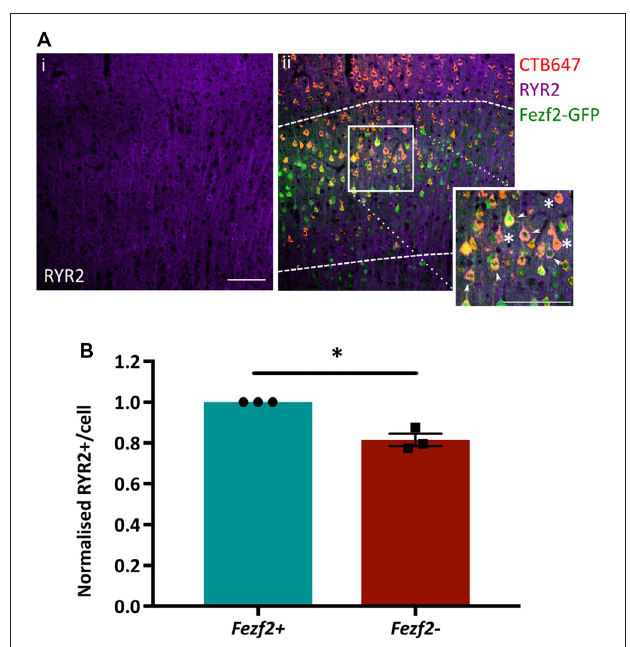
FIGURE 6 | Validation of enriched RYR2 expression in Fezf2+ve IT-PNs by immunohistochemistry. Coronal sections from CTB647 injected Fezf2-Gfp mouse were labeled for Ryanodine receptor 2 (RYR2) expression and images captured in M1. (Ai) RYR2 expression in M1. (ii) Image shows co-expression of RYR2 (purple) with Fezf2+ve IT-PNs (green and red; arrowhead) and Fezf2 − ve IT-PNs (red; asterisk). Dashed lines indicate layer 5 from which cells were selected for quantification. Scale bar is 100 µ m. (B) Normalized percentage area of cell body labeled for RYR2 expression in Fezf2+ve and Fezf2 − ve IT-PNs. There is a significant decrease of RYR2 protein expression in Fezf2 − ve IT-PN cell bodies ( p < 0.05, paired t -test, n = 3; ±